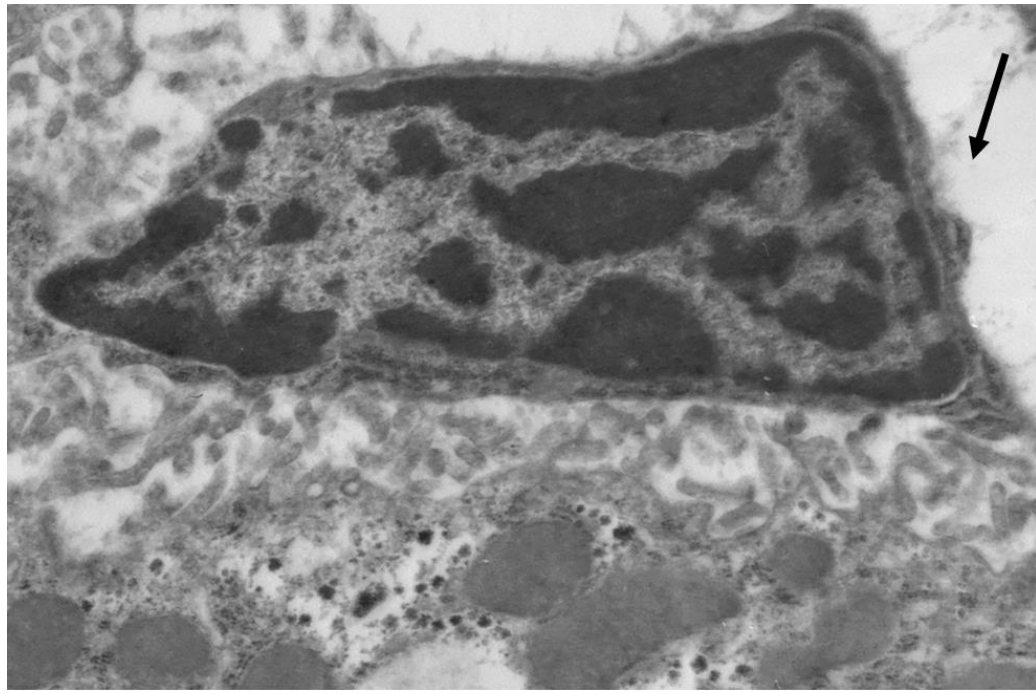
Figure 8. Lipid inclusions (arrow) in cytoplasm of macrophage in liver of mice 24 h after P-407-induced hyperlipidemia, e ff ect of mannan B pretreatment. Magnification 6000 ×